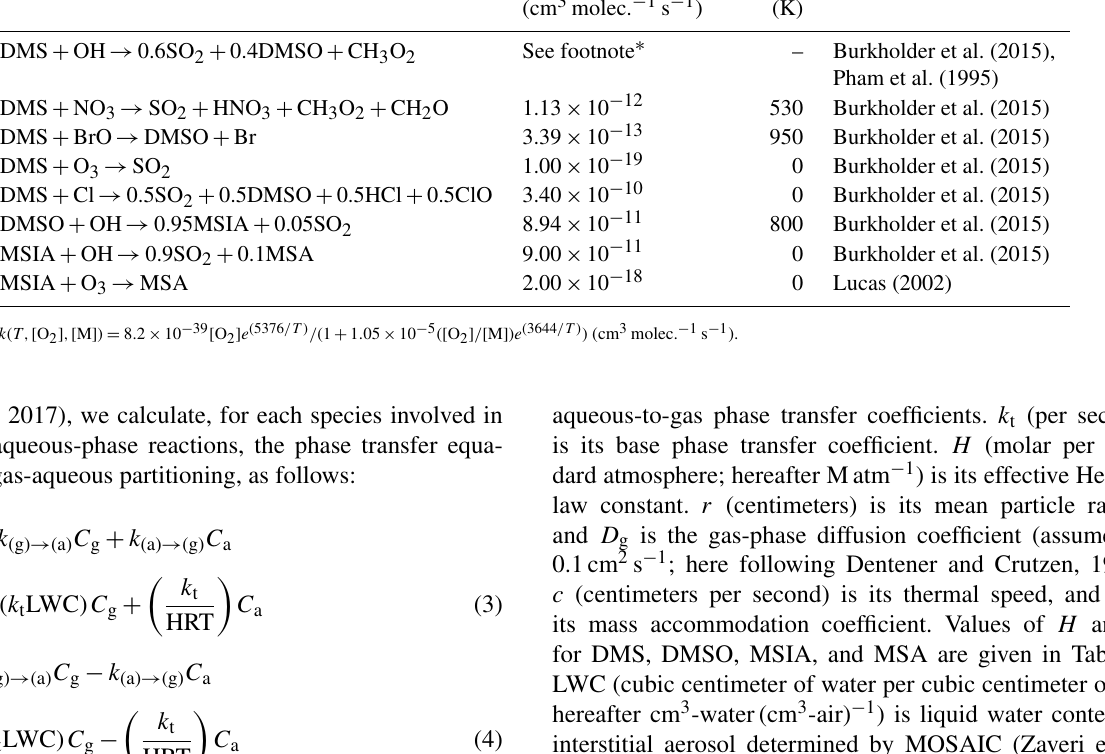
Table 6. Gas-phase DMS oxidation (OH-addition pathway) implemented into CAM6-chem in this study. Gas-phase